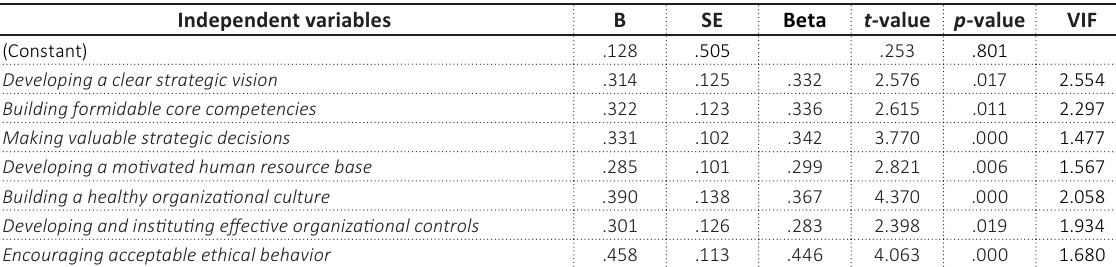
Table 7. Regression coefficients –